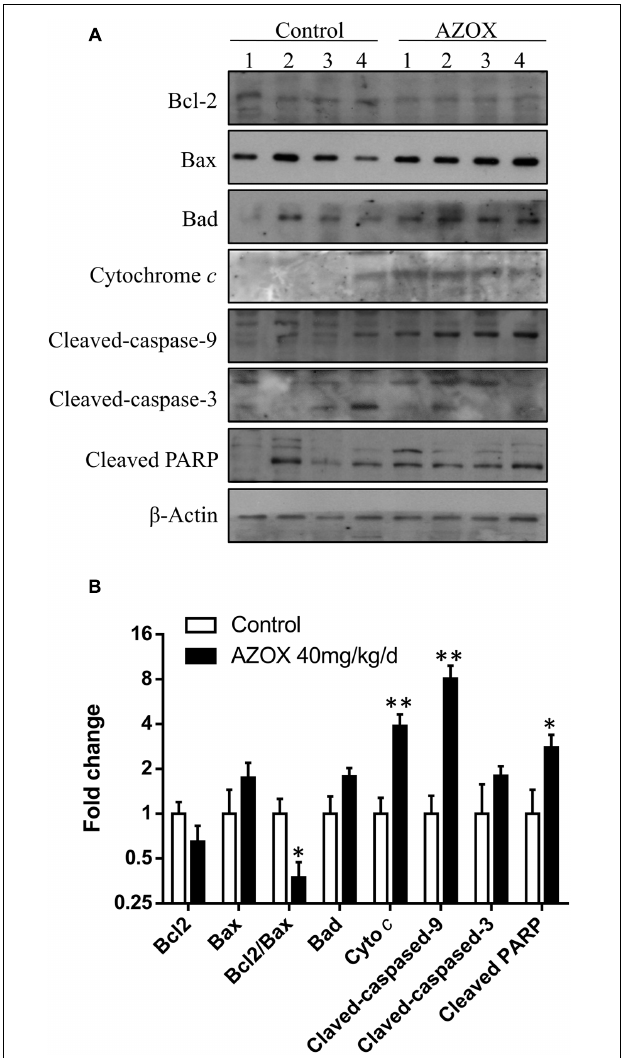
FIGURE 6 | AZOX abrogates the in vivo tumor growth through activating the intrinsic apoptosis pathway. (A) The tumors dissected from the nude mice were homogenated and subjected to the total protein extraction followed by western blot analysis to detect the expression of cleaved PARP, Bcl-2, Bax, Bad, cytochrome c , and the cleaved caspases. (B) Statistical charts of the western blot results. All data are represented as means ± SEM of three independent experiments ( ∗ p < 0.05 and ∗∗ p < 0.01).